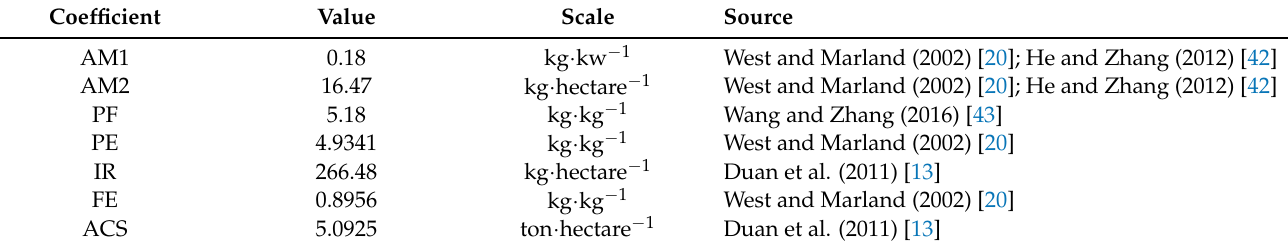
Table 1. The carbon emission